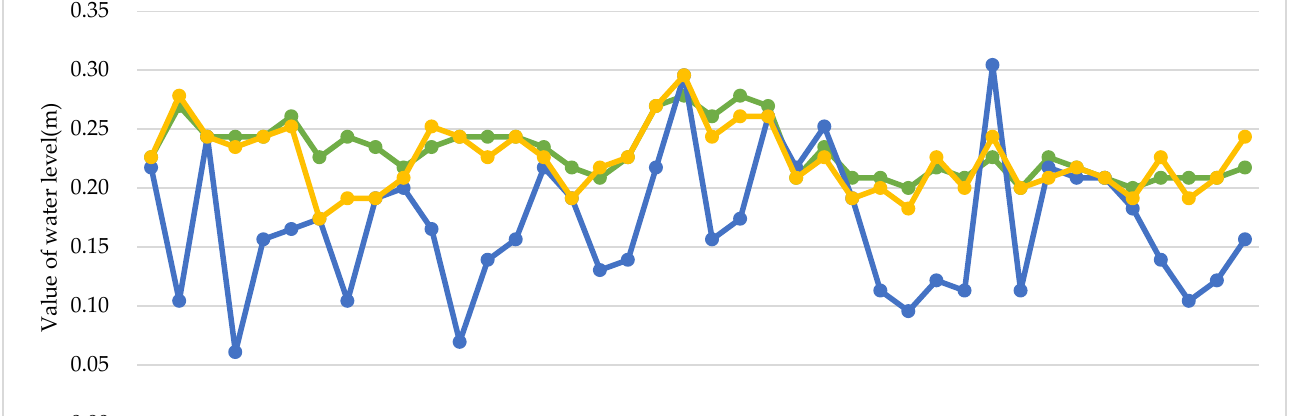
Figure 23. Comparison of time loss. The orange columns show the time loss of intelligent recogni- tion. The blue columns represent the template matching. The ordinate represents the sequence num- ber of the image and the abscissa represents the value of the time loss (the unit is s). Table 2. The results of the comparison between the template matching algorithm and the intelligent recognition algorithm designed for this experiment. The accuracy and time loss of these two algo- rithms were compared using manual readings as the standard. Each of the manual readings is the average of three manual readings. Ruler No